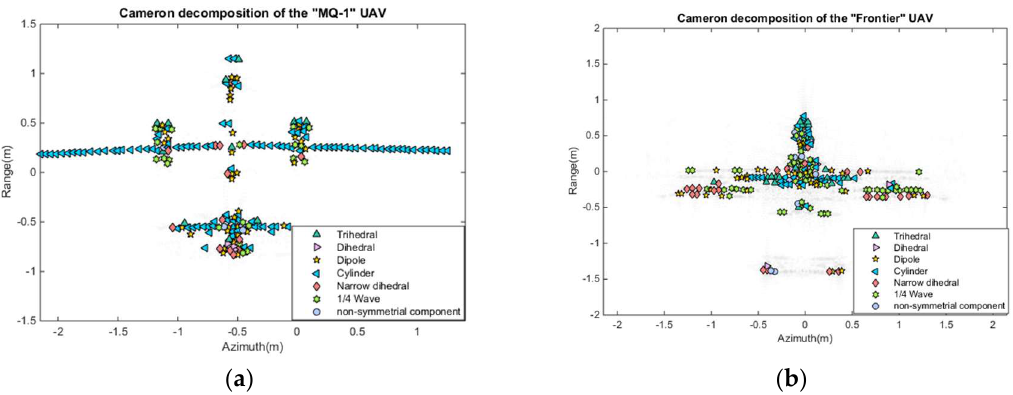
Figure 13. The Cameron decomposition of the “MQ-1” and “Frontier” UAVs. ( a ) “MQ-1” UAV; ( b ) “Frontier” UAV.